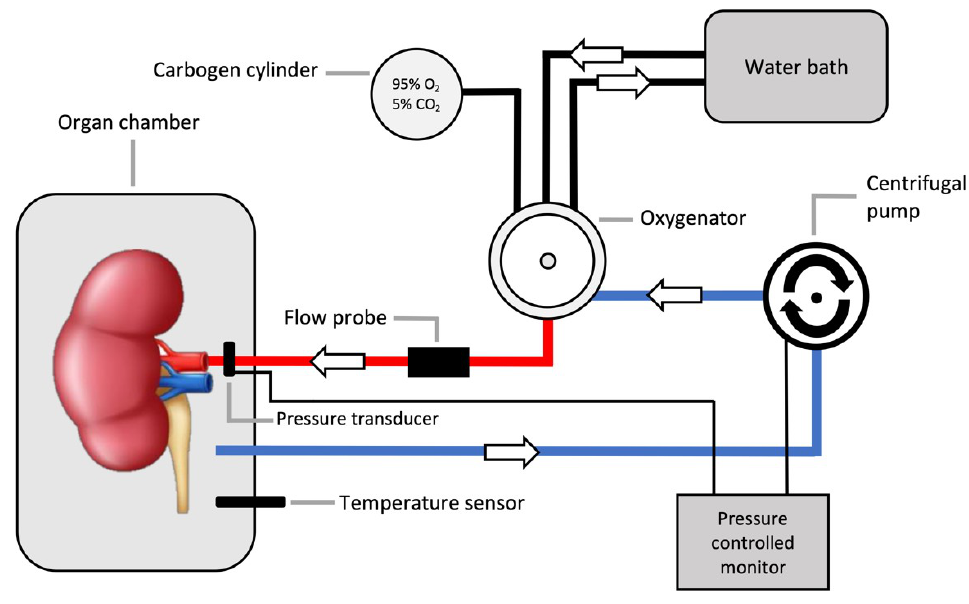
Fig 1. Schematic figure of the normothermic perfusion